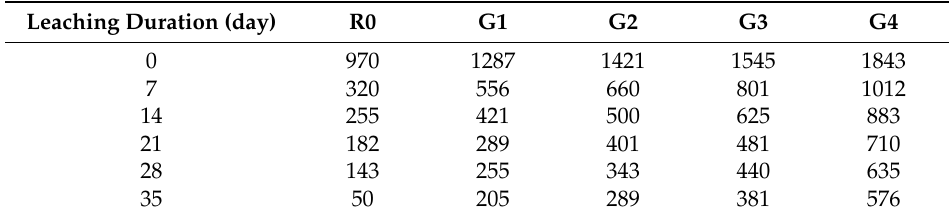
Table 5. Fitting results of R CCP based on the modified model (Q mat (Q DP R CP ) R CCP ) (Q L R L ) for the leached samples at different leaching durations (Ohms).